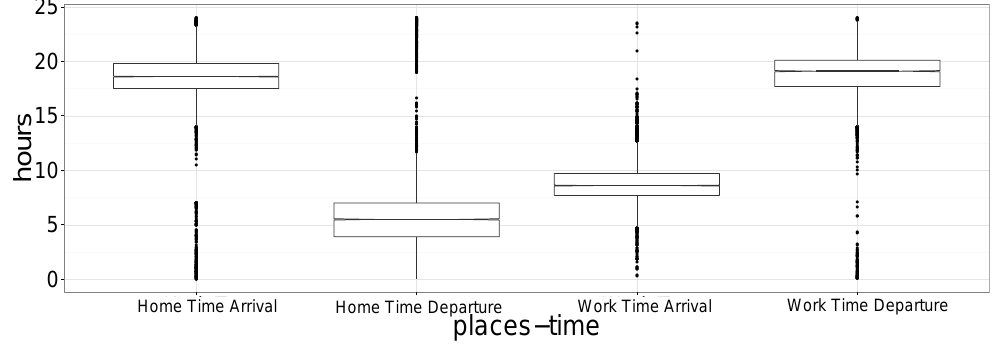
Figure 4. Distribution of all the estimated t arrival and t departure for home and work locations. Considering median time, people leave home at about 6 a.m. at arrive at work at 8 a.m. Then, they leave work at about 7 p.m. and arrive at home at the same time.